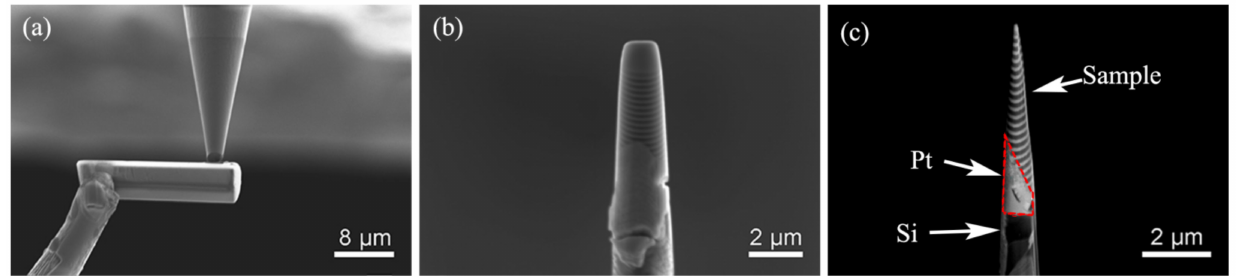
Figure 5. Welding process of single-wedge lift-out. ( a ) Welding; ( b ) sample enlarged view; ( c ) sample fine